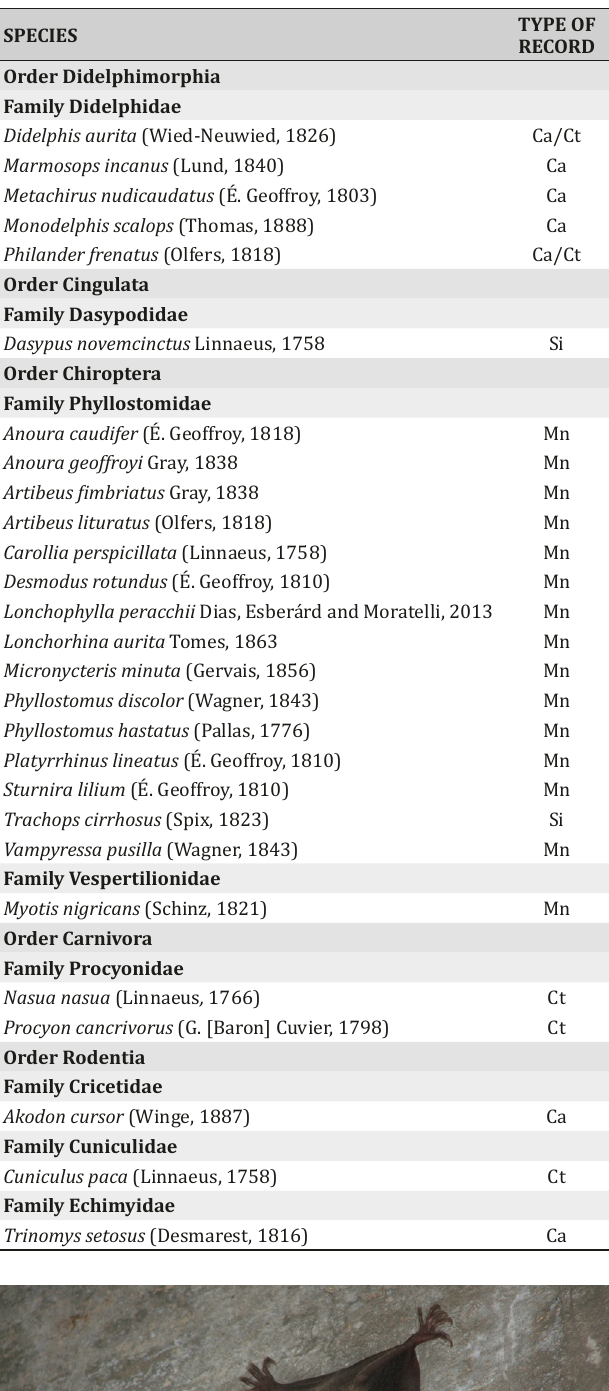
Table 1. Species list of mammals from Cambuci, state of Rio de Janeiro, southeastern Brazil.